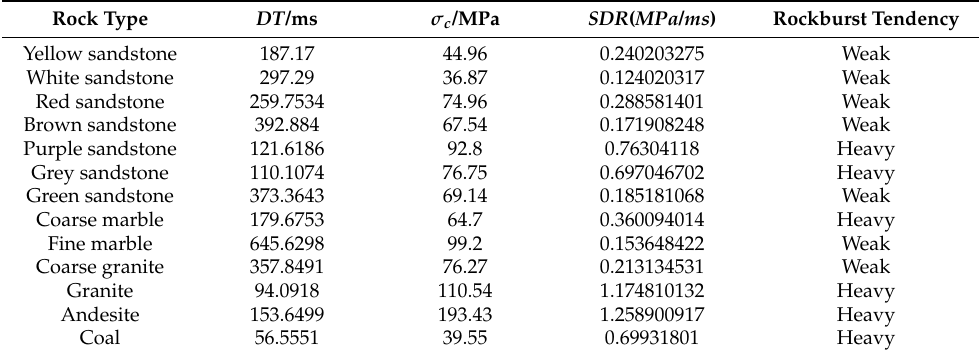
Table 4. SDR values of rocks tested in uniaxial compression tests.